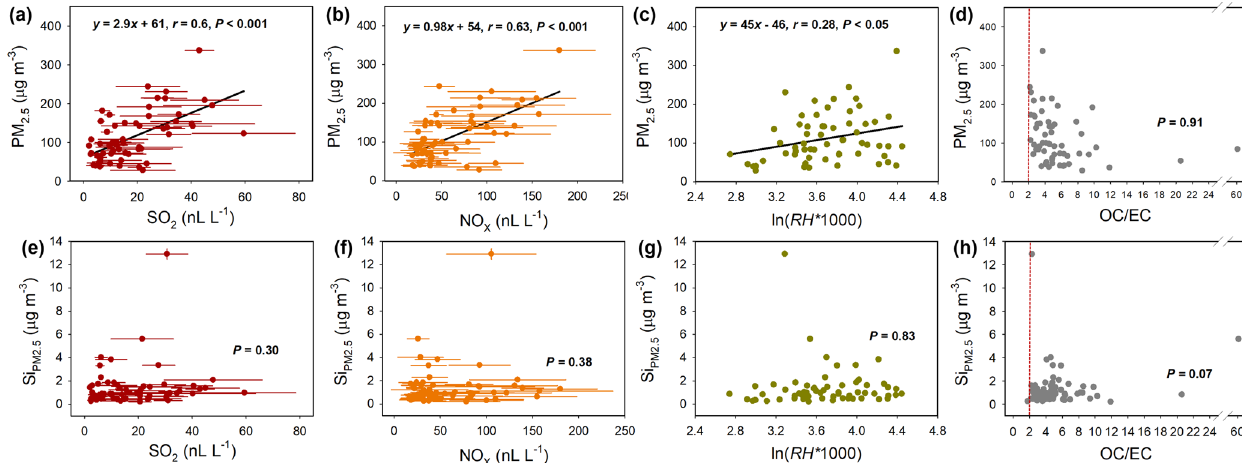
Figure 3. Correlation analysis of PM 2 . 5 concentration and Si PM (a–d) . Correlation of PM 2 . 5 concentration with SO 2 (a) , NO x (b) , RH (c) , and the OC / EC ratio (d) . (d–f) . Correlation of Si PM (e) , NO x (f) , RH (g) , and the OC / EC ratio (h) . The red dotted lines in ( d ) and (h) represent OC / EC = 2, which can be used to indicate the formation of secondary aerosols at OC / EC > 2 (Chow et al.,